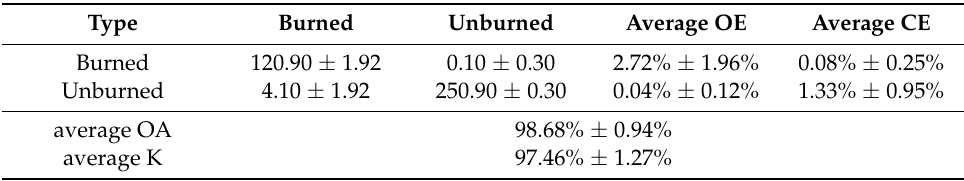
Table 6. Average error matrix of accuracy assessment by a 10-fold cross-validation method. (The values are the mean and its standard deviations; the columns of the error matrix represent the actual types, and the rows represent the predicted types of the proposed method.).